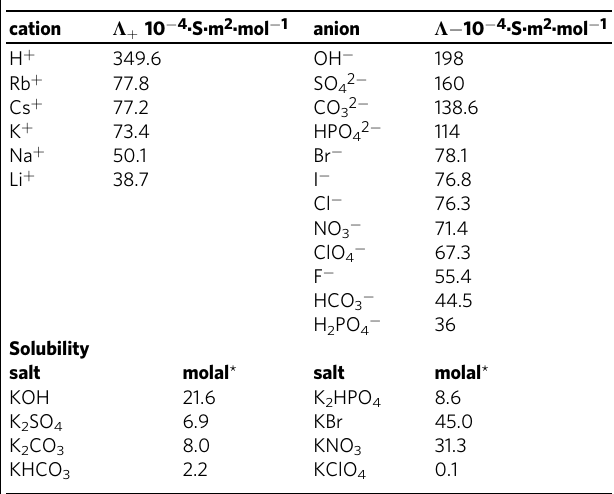
Table 1 Electrolyte compositions for CO 2 electrolysis.